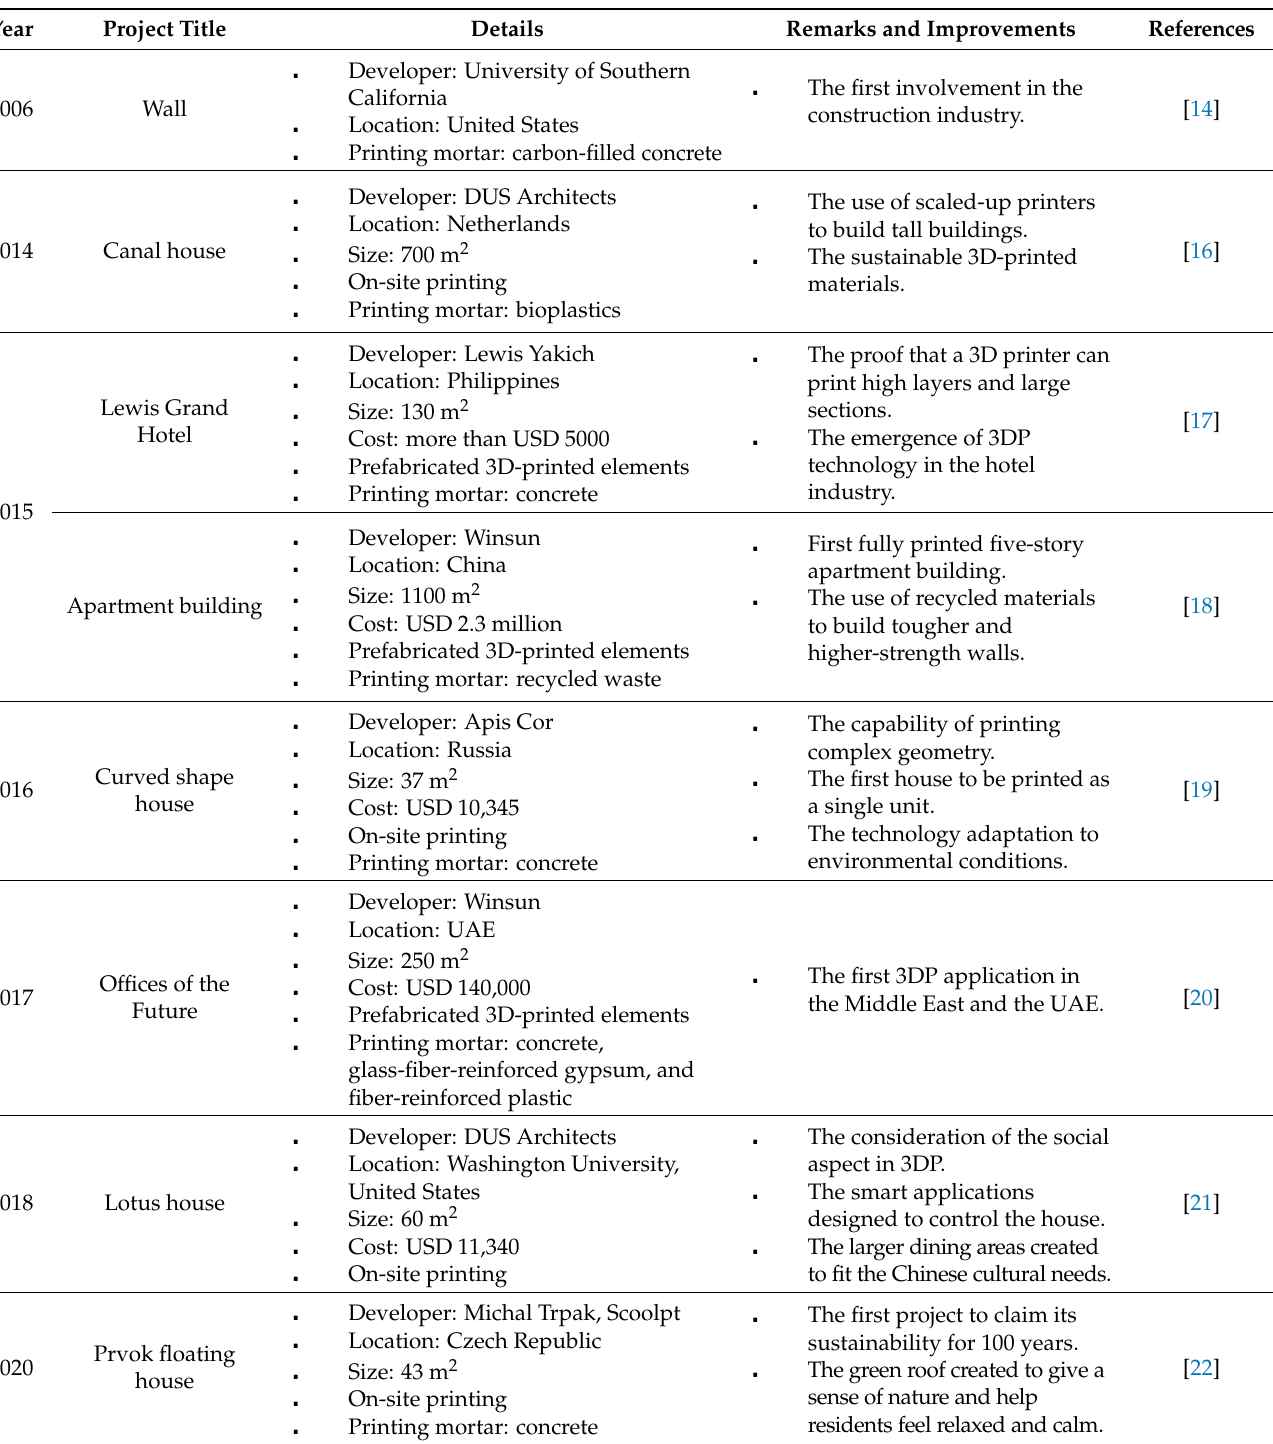
Table 1. Summary of selected major 3D-printed construction